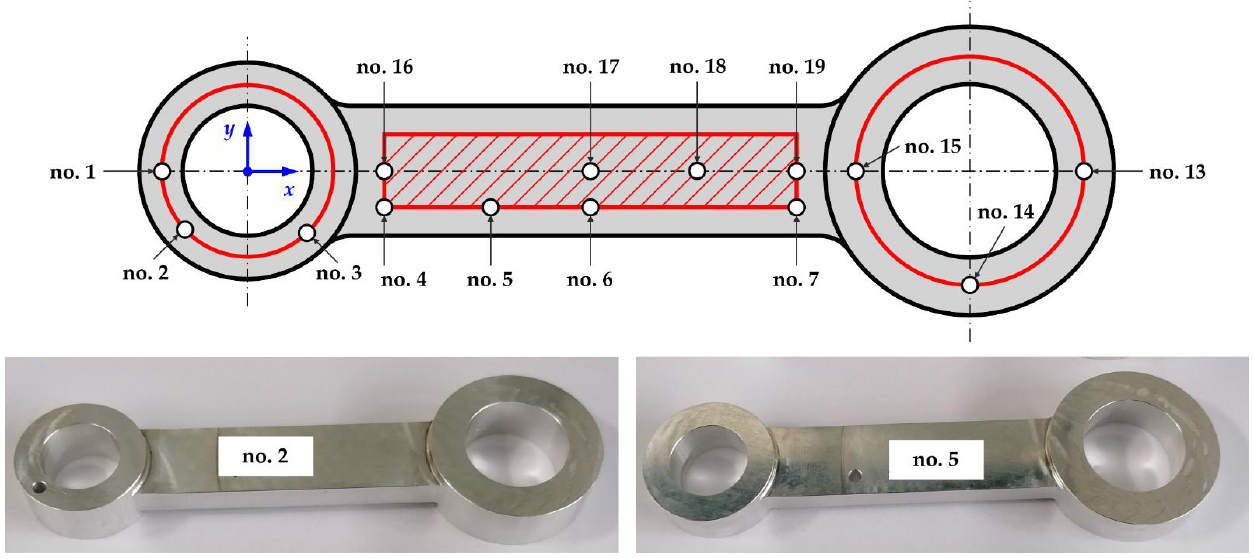
Figure 8. Defect positions for the machine-made connecting rods and photos of two machine-made parts with a through-hole defect in its final size of 3 mm (the given numbers refer to the numbers/designations of the machine-made parts and indicate the defect position depending on part no.).